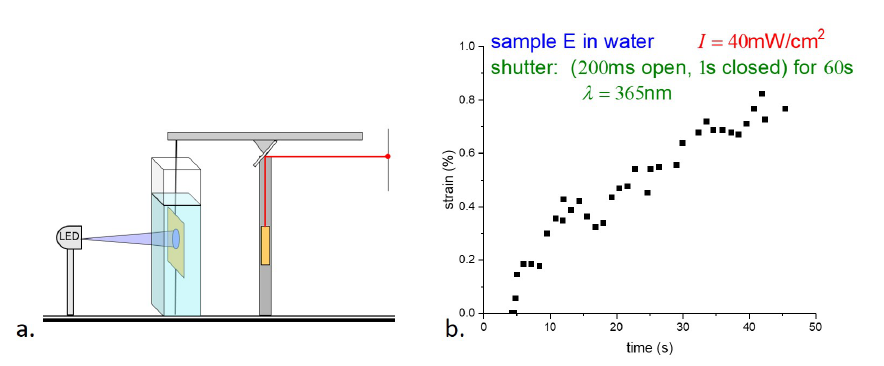
Figure 8. ( a ) Schematic of the experimental setup for photostrain measurements. ( b ) Results of phototstrain measurements.